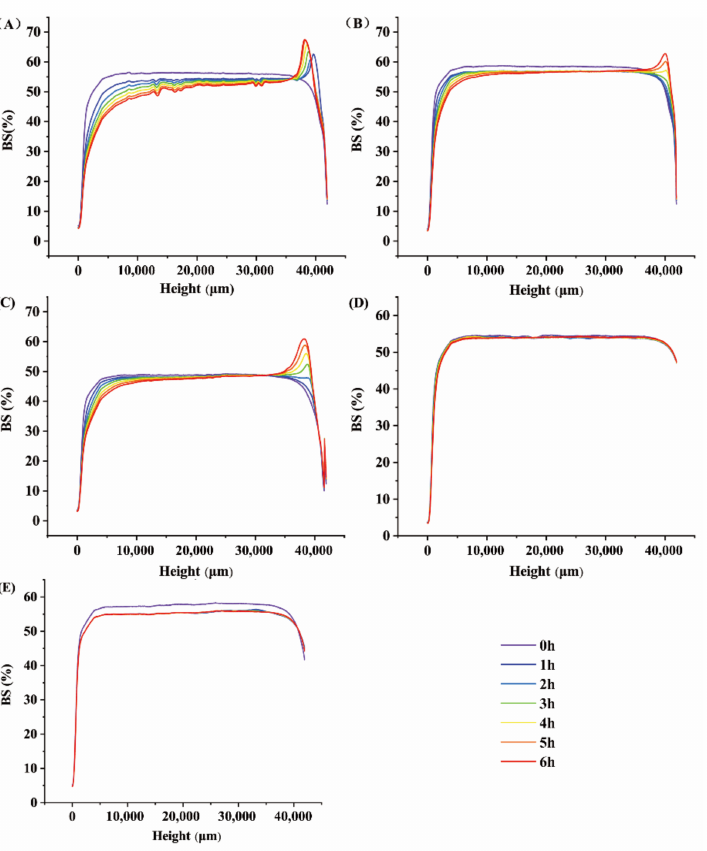
Figure 3. Effect of HA concentration of 0.100% ( A ), 0.125% ( B ), 0.150% ( C ), 0.175% ( D ), and 0.200% ( E ) on the stability of β -carotene